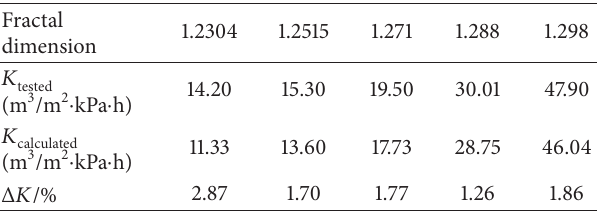
Table 4: Air permeability ( 𝐾 ) of porous metal materials made by irregular powder with the particle size of 44 ∼ 74 𝜇